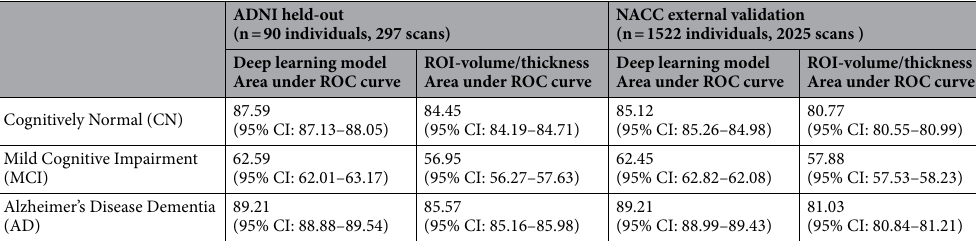
Table 2. Classification performance in ADNI held-out set and an external validation set. Area under ROC curve for classification performance based on the deep learning model vs the ROI-volume/thickness model, for ADNI held-out set and NACC external validation set. Deep learning model outperforms ROI-volume/ thickness-based model in all classes.